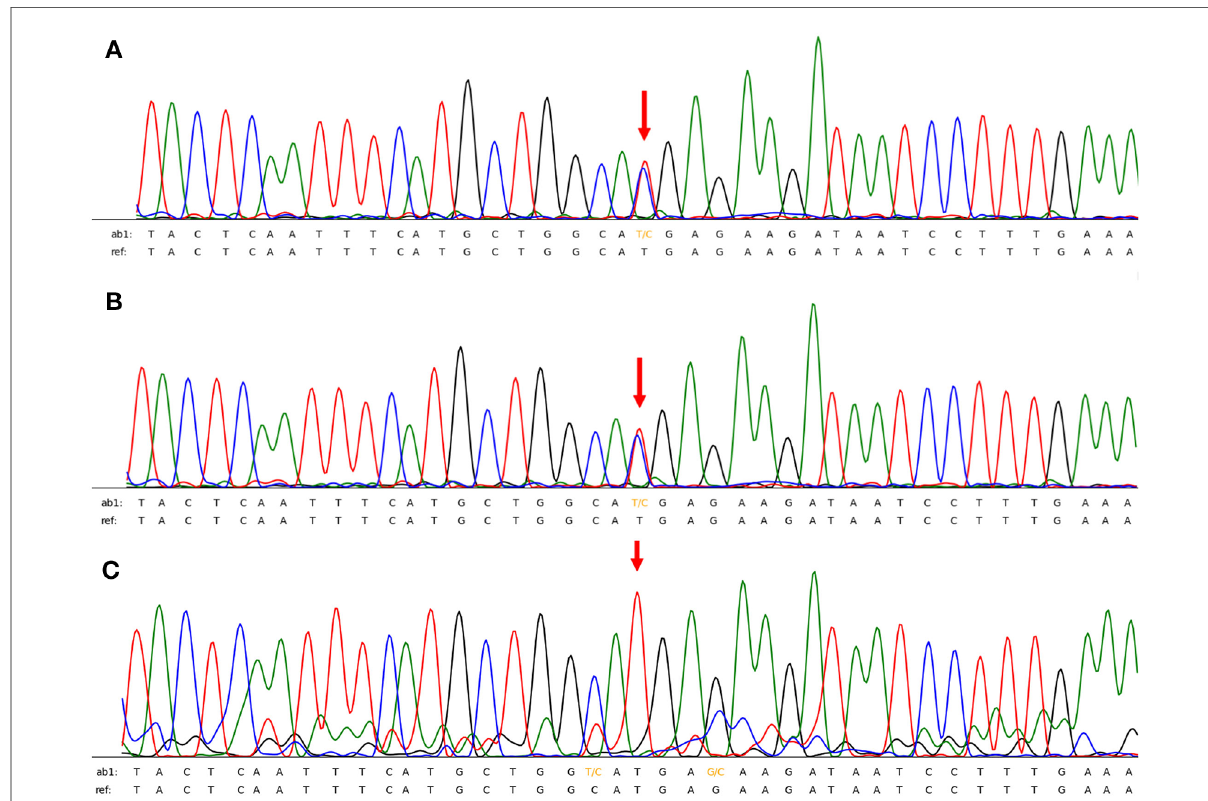
FIGURE 2 ( A,B ) the patient and her mother had a heterozygous mutation of AKAP9 gene mutation of c.11714T>C (p.M3905T). ( C ) Her father had no relevant genetic